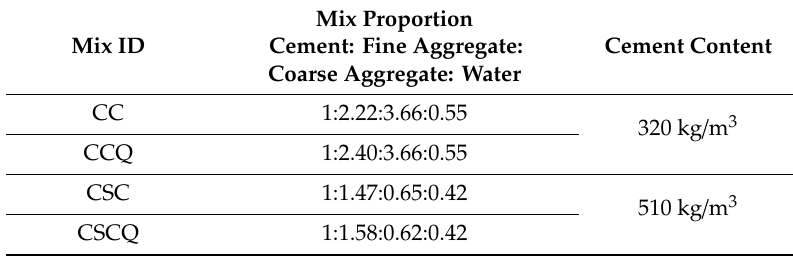
Table 2. Mix proportions used for di ff erent concrete mixes.